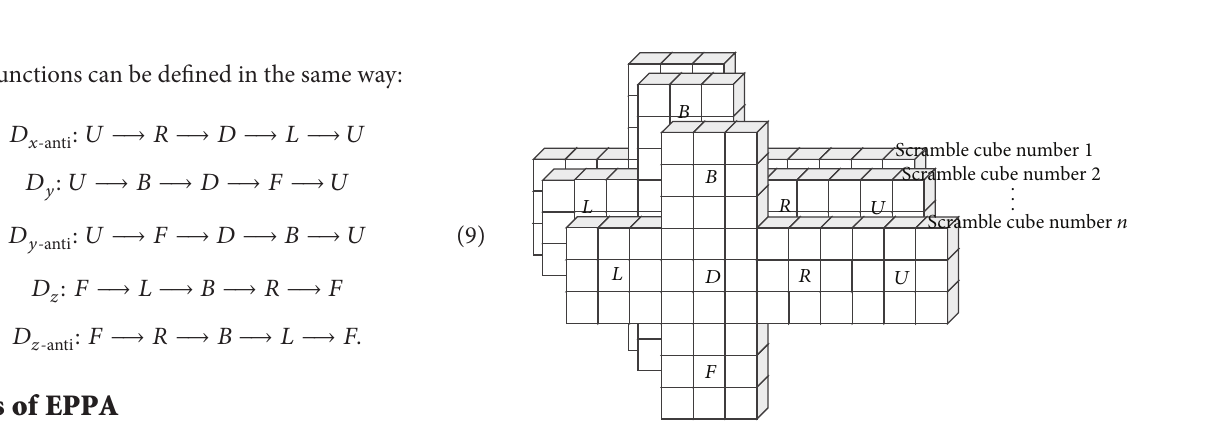
Figure 3: 3 × 3 × 3 scramble cube with 54 bytes of data. Figure 4: Unfolded 3 × 3 × 3 scramble cube.